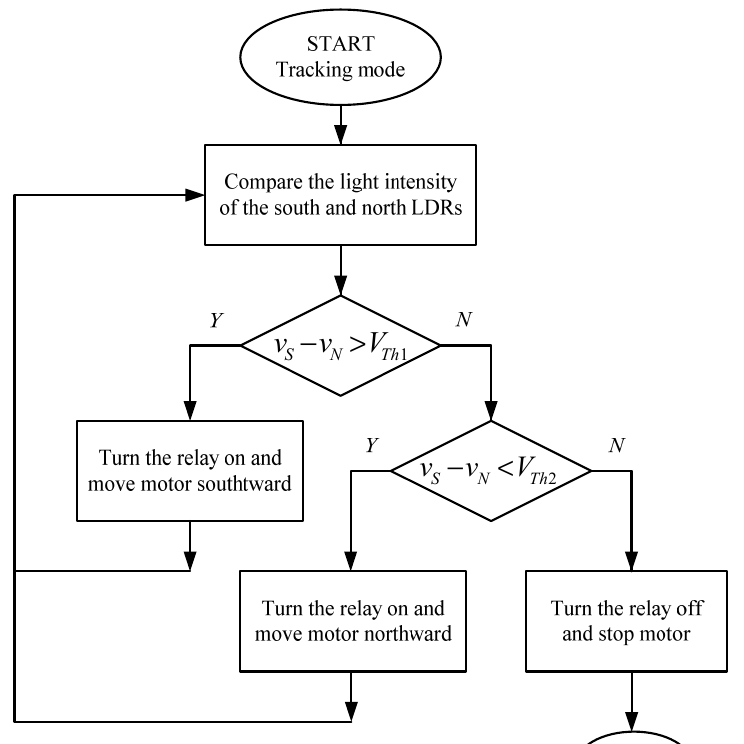
Figure 3. Flowchart of tracking algorithm for elevation